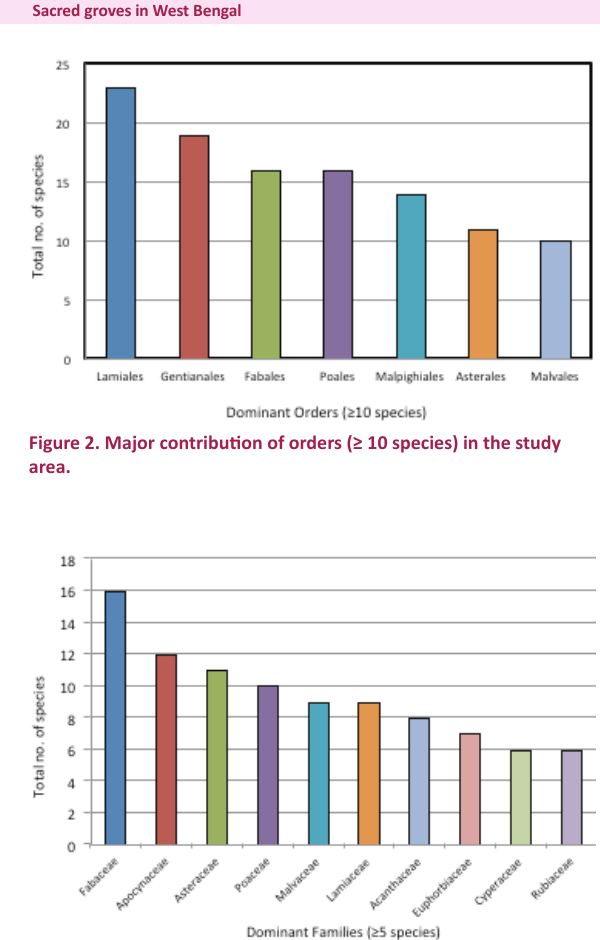
Figure 3. Major contribution of families (≥5 species) in the study area.